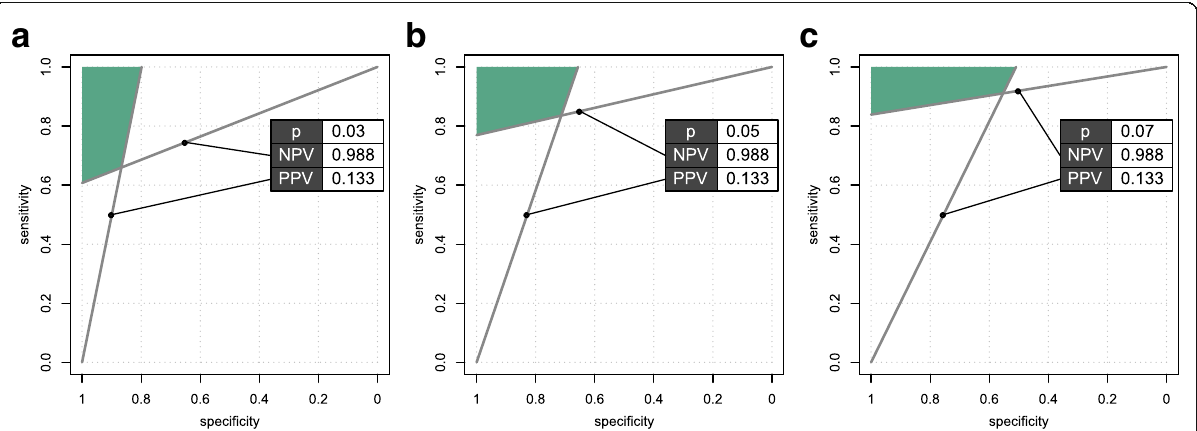
Fig. 4 a – c Equi-PPV and equi-NPV lines corresponding the pre-eclampsia risk in multiparous pregnant women with previous pre-eclampsia (PPV) or without previous pre-eclampsia (NPV). These minimal prognostic performance thresholds are calculated for three different pre-eclampsia prevalence values, as reported for first-time pregnant